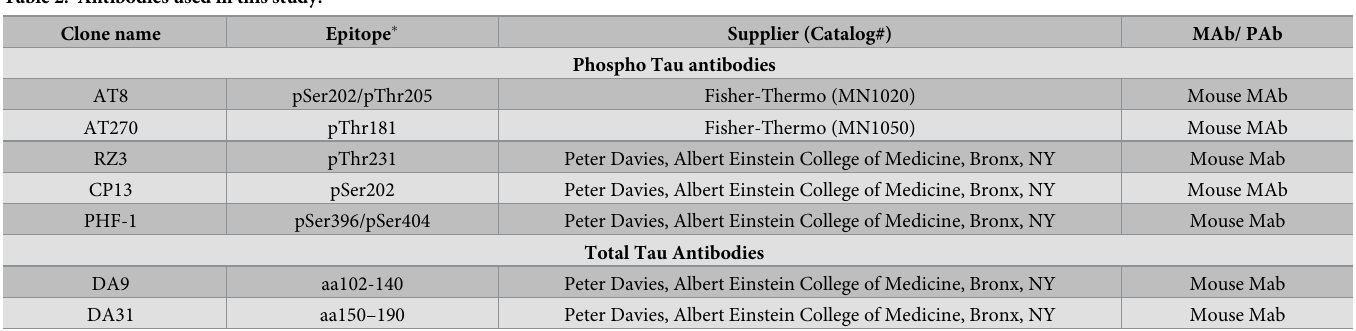
Table 2. Antibodies used in this study. Clone